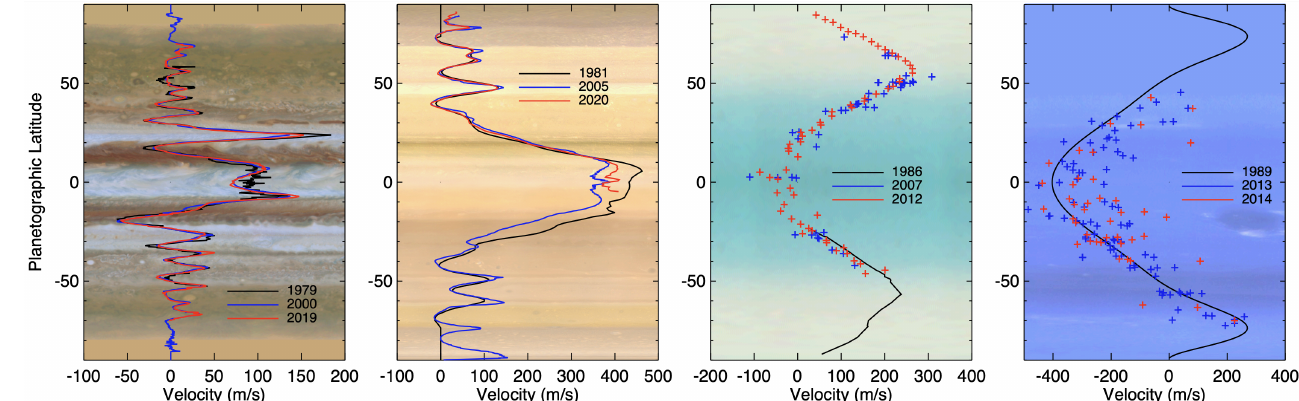
Figure 12. The giant planets’ zonally-averaged winds measured over time. In all four panels, the black profile is from Voyager imaging measurements; for Neptune, the best-fit profile for southern latitudes is mirrored above 50 ◦ N [123]. Jupiter’s winds show only small variations between Voyager (1979), Cassini (2000), and Hubble (2019) imaging measurements [94,126,131], primarily in the strongest eastward jet; map from Hubble 2015 data. Saturn shows substantial change at the equator between the Voyager (1981), Cassini (2004–2006), and Hubble (2020) eras [14,94]; map from Cassini and Voyager 2 by B. Jonnson. Uranus shows very little variation between Voyager (1986), Keck (2007), and Keck/Gemini (2012) [24,105,116]; map from Hubble 2021 data, mirrored for southern hemisphere coverage. Neptune’s winds show large dispersion over from the Voyager (1989) profile and within a single filter (Keck H-band measurements are shown for 2013 and 2014) [34,123]; map from Voyager 2 up to 50 ◦ , B.